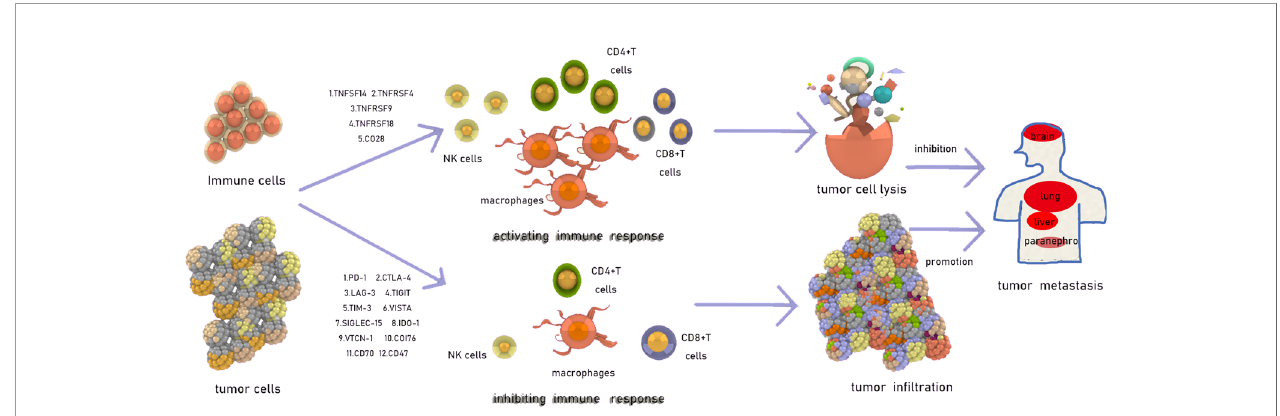
FIGURE 1 | The introduction of immune